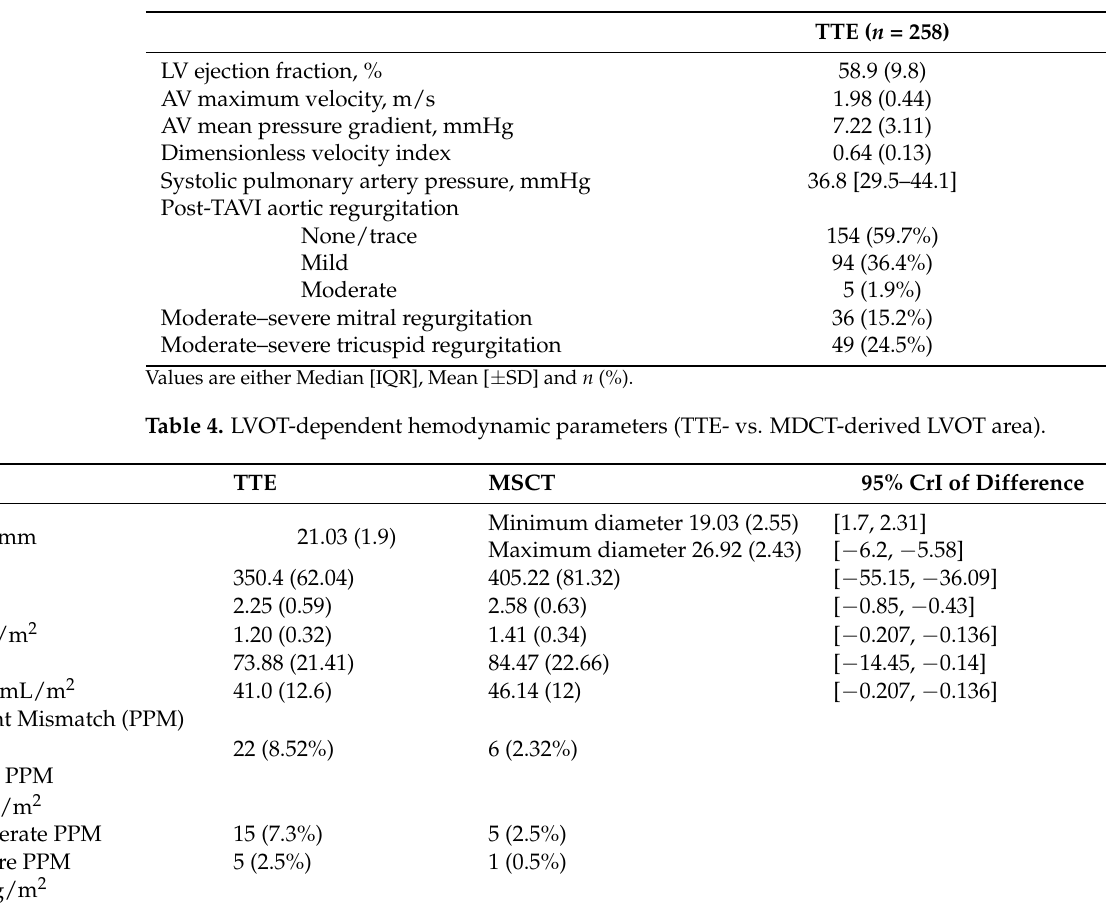
Table 3. Post-procedural TTE-Doppler assessment.